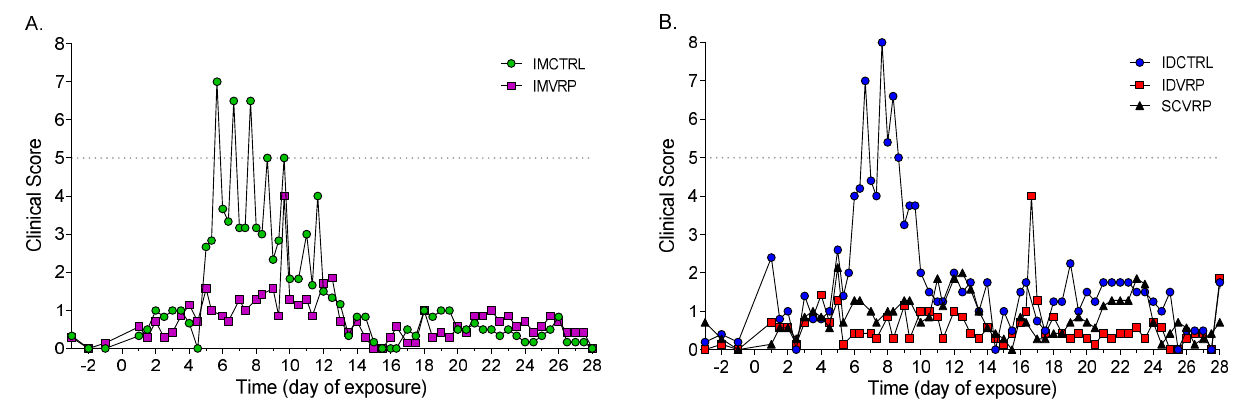
Figure 4. Average clinical scores. ( A ) IM-control and IM WEVEE VRP-NHPs ( n = 6, and 7 respec- tively). ( B ) ID-control, ID WEVEE-VRP, and SC WEVEE VRP-NHPs ( n = 5, 7, and 7 respectively).